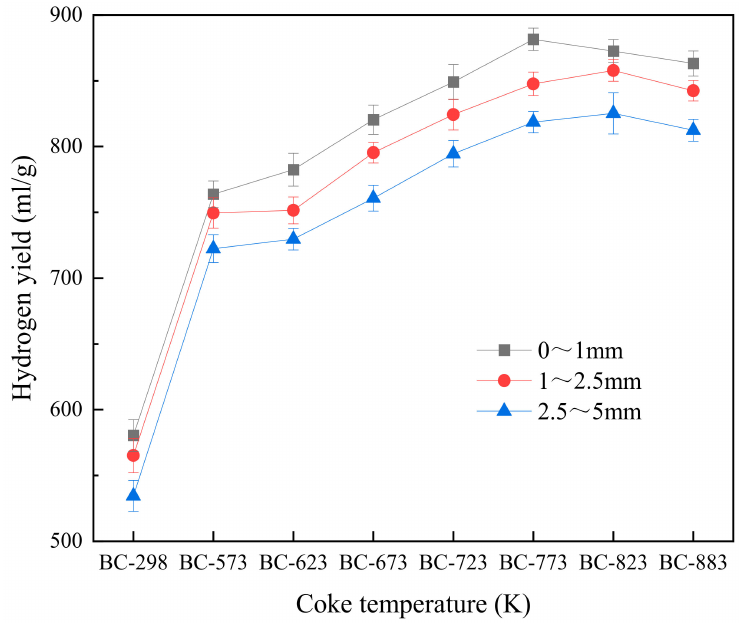
Figure 3. Hydrogen yield from semi-coke